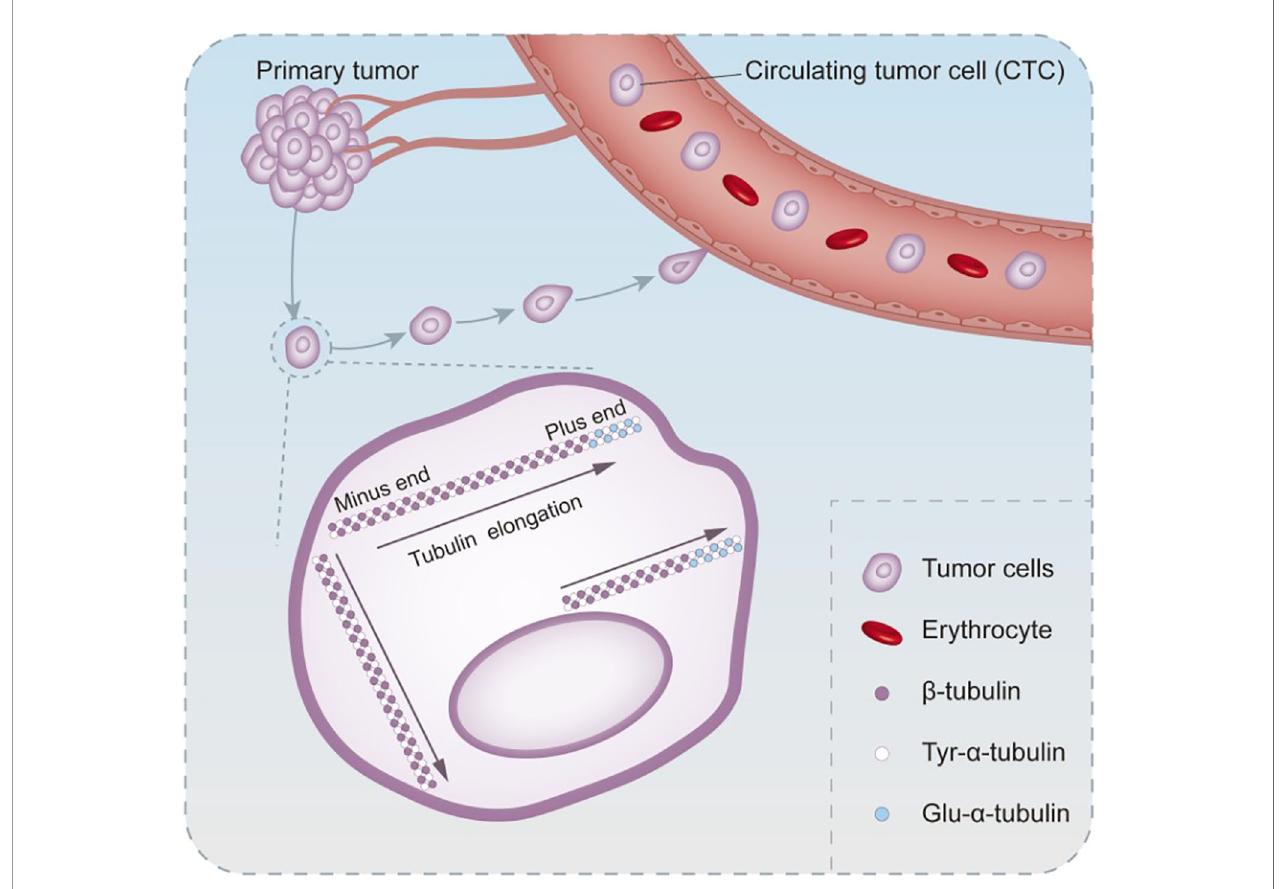
FIGURE 1 | The process of altered microtubule stability in circulating tumor cells undergoing EMT. Post-translational modi fi cation of the microtubule constituent protein a -microtubulin occurs when the tyrosine at the carboxyl terminus is replaced by a glutamate residue. Glutamate microtubules are more stable than tyrosine microtubules, and glutamate microtubules extend in the same direction as CTCs